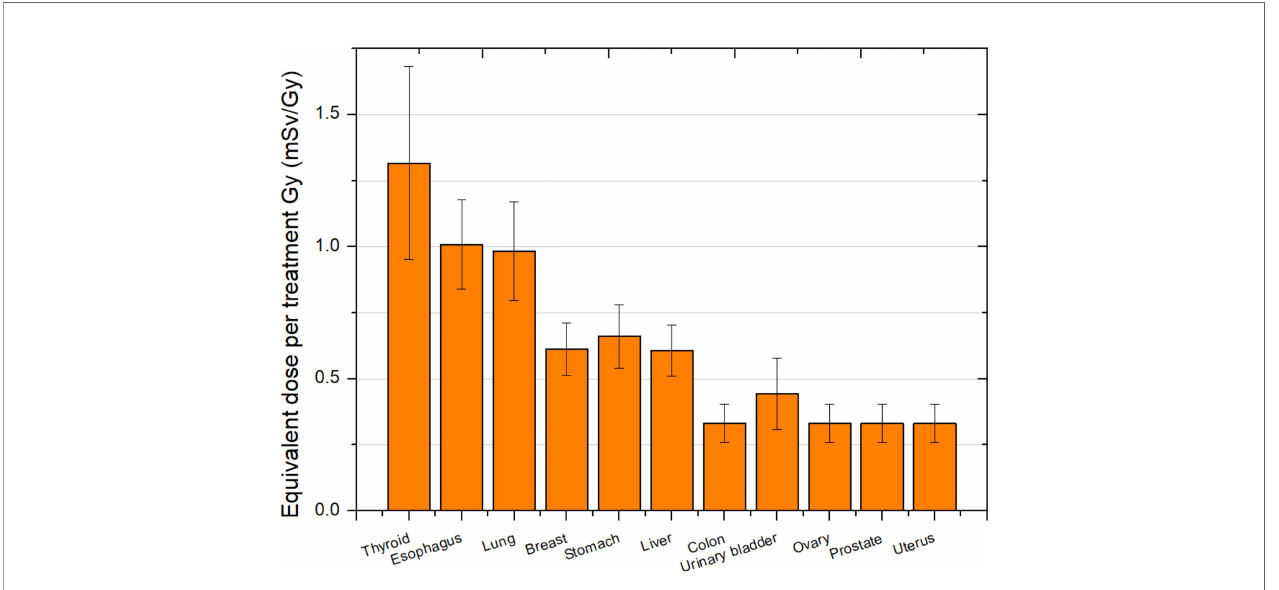
FIGURE 7 | Total equivalent dose in organs per treatment Gy for a head treatment.